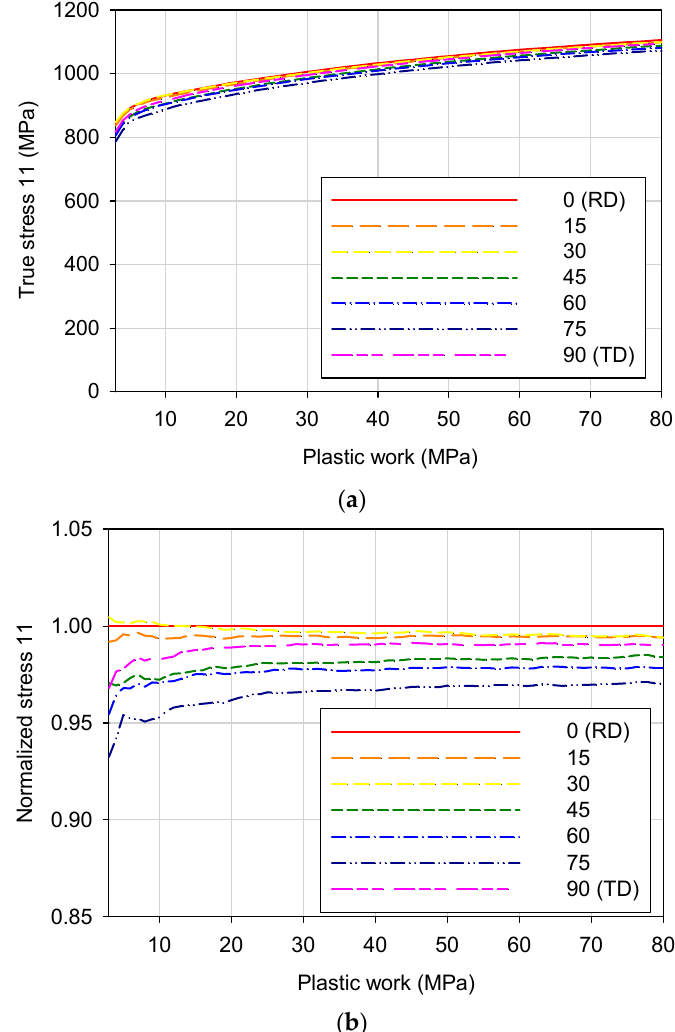
Figure 5. Measured ( a ) yield stress and ( b ) normalized yield stress evolutions for the Q&P 980 steel with respect to the plastic work.